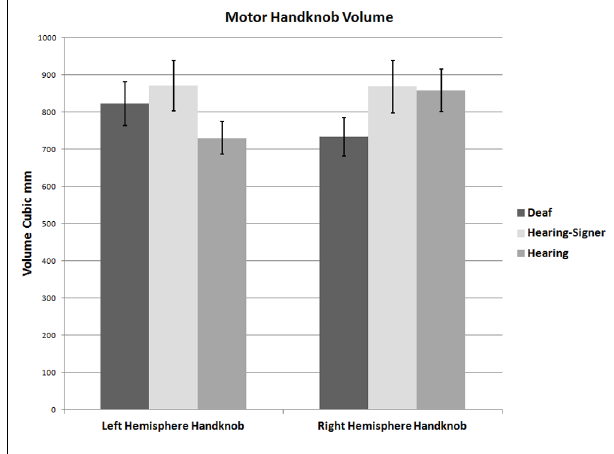
FIGURE 4 |Volumes of the left and right handknobs (error bars: ± 1 standard error).